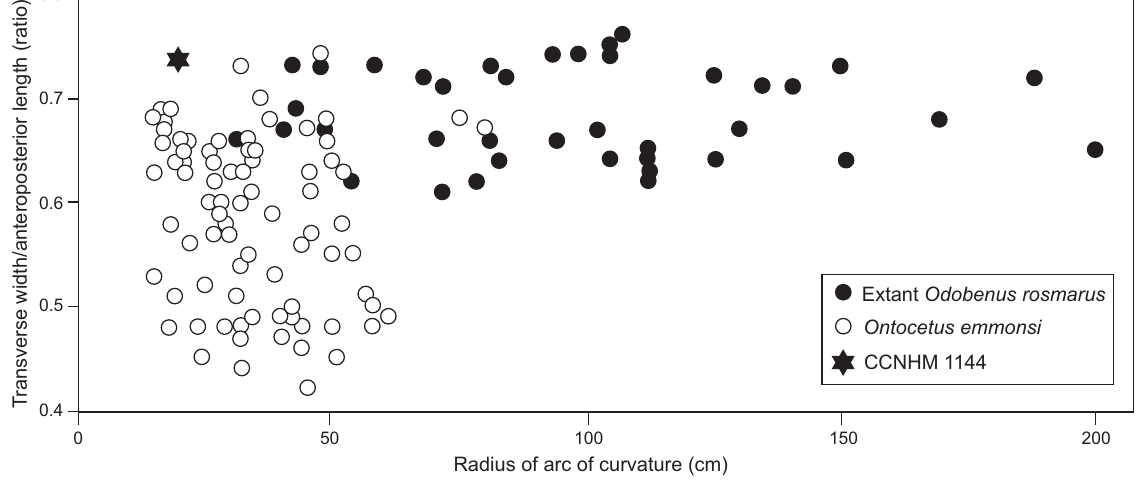
Fig. 3. Scatterplot of ratio of proximal transverse width/anteroposterior length versus radius of the arc of curvature for tusks of Odobenus and Ontocetus , including CCNHM 1144. Original plot modified from Kohno and Ray (2008: fig.